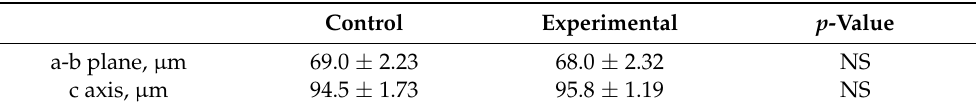
Table 5. The effect of infecting C. perfringens on the hydroxyapatite nanocrystallites size in the bone tissue of the tibia in examined animals at the age of 42